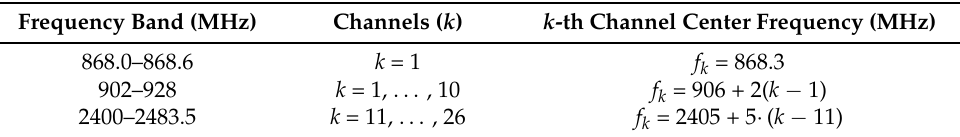
Table 1. Channels definitions in ZigBee technology (IEEE